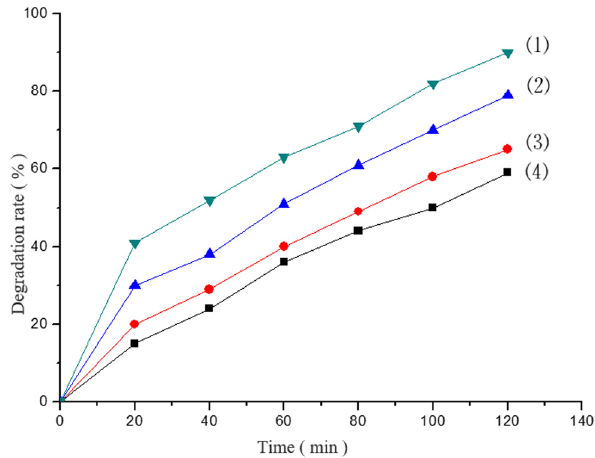
Figure 9: Under certain conditions, the Ce/Ag/ZnO and Ag/ZnO sample degradation rates of the methyl orange contrast curve. ( 1 ) the Ce/Ag/ZnO sample group, ( 2 ) the Ag/ZnO sample group, ( 3 ) surfactant SDBSwithnosamplesinthecontrolgroup, ( 4 ) surfactant PAAS with no samples in the control group.